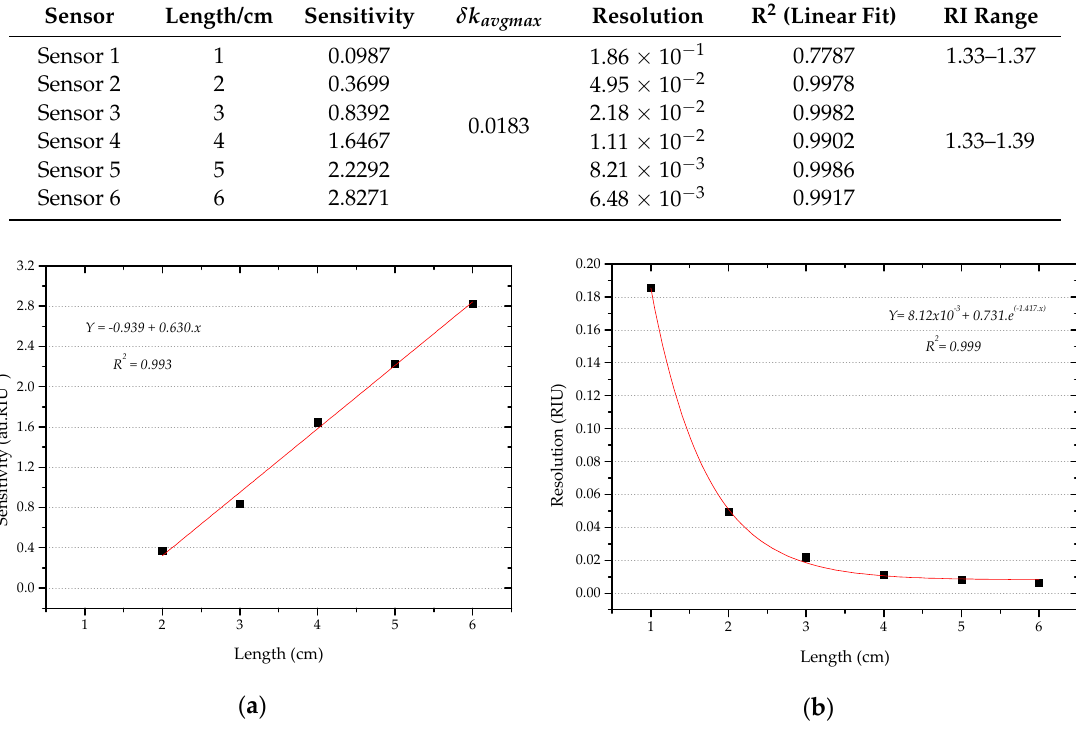
Table 1. RI: 1.33–1.39—Sensitivity and resolution of the D-shaped sensors, given by Equations (6) and (7).